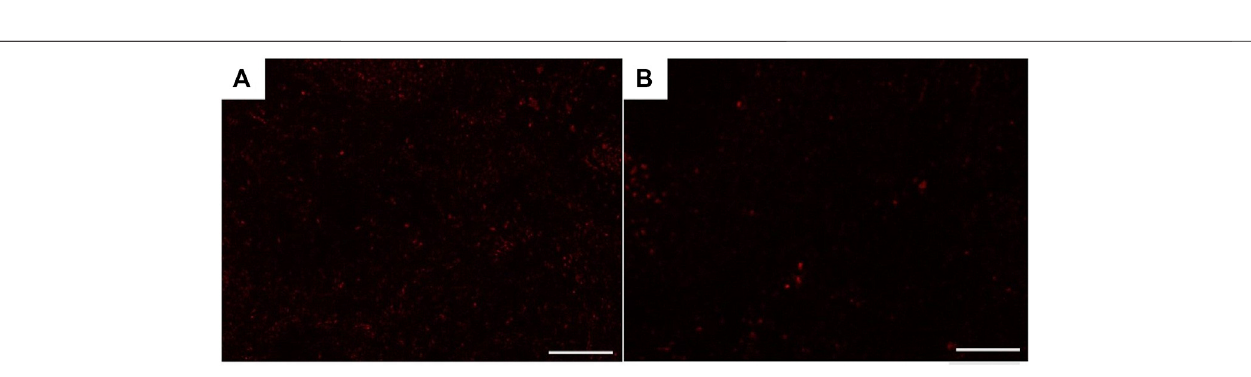
FIGURE 14 | Fluorescence microscopic photomicrographs showing recruitment of PKH26-labeled USCs in the corpora cavernosa of group III rats 4 weeks (A) and 8 weeks (B) after transplantation. Scale bar: 100 μ m.